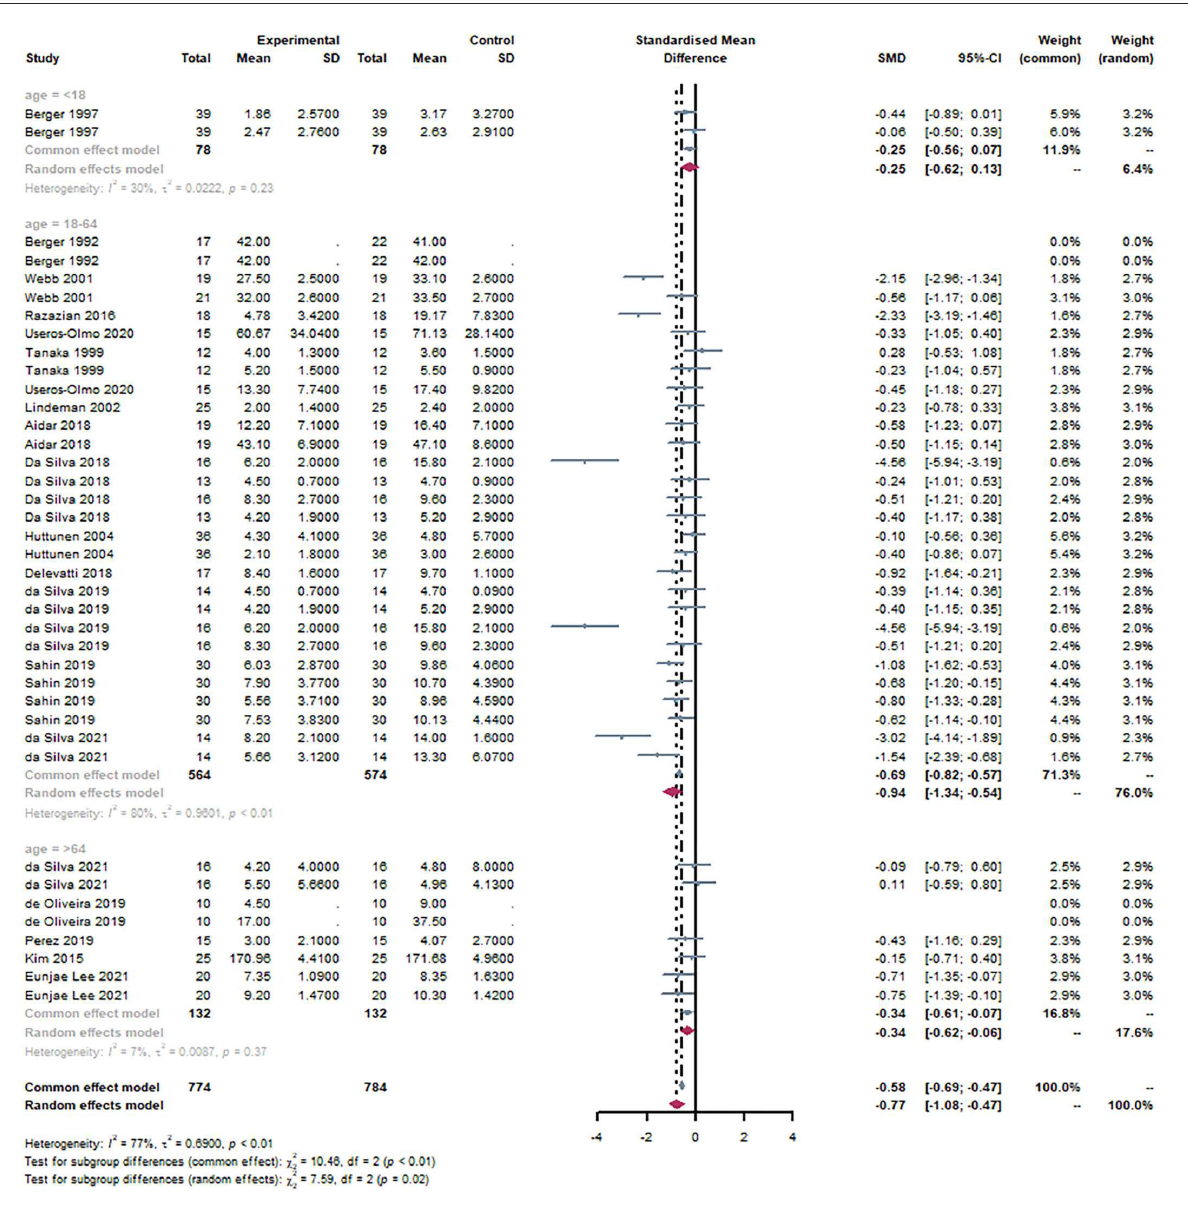
P < 0.01] were statistically significant through the subgroup